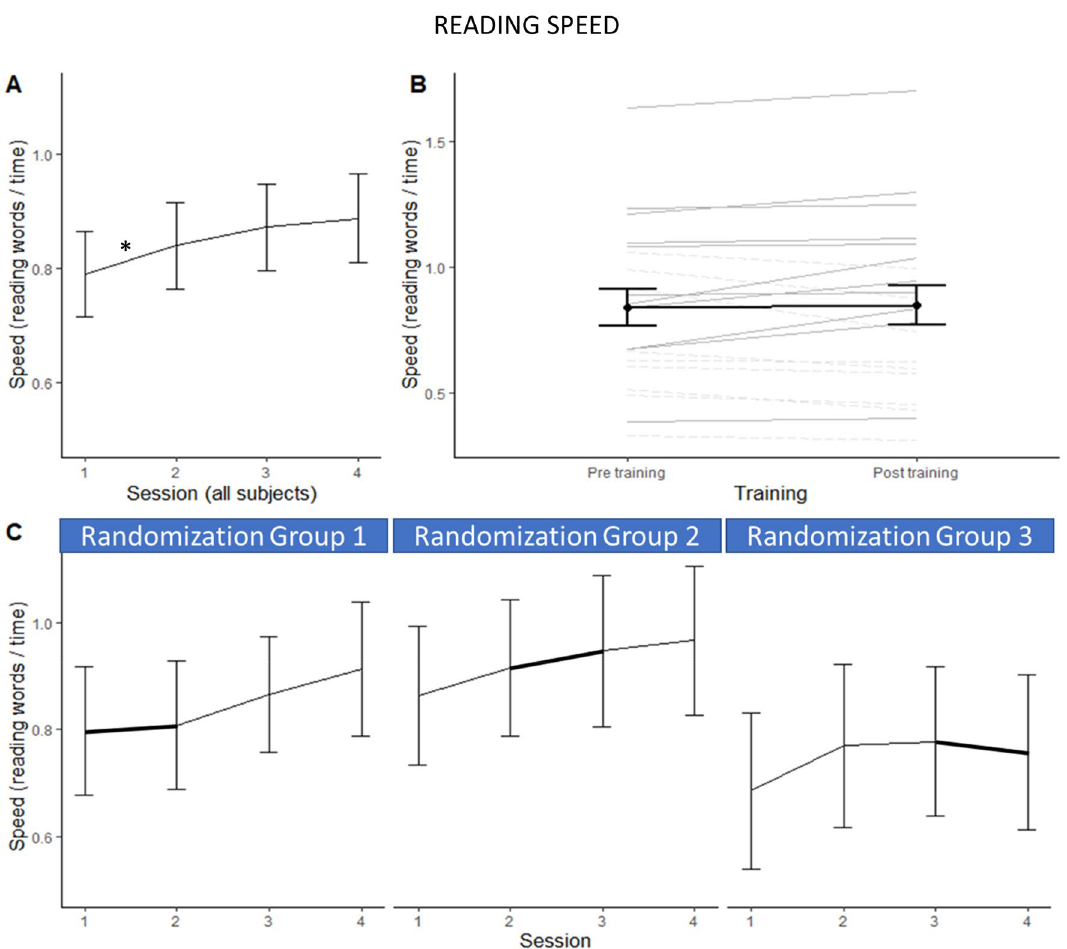
Figure 4. Mean reading speed and standard errors at the four reading sessions in the whole dyslexic group ( A ) and separately for the 3 randomization groups performing the visual search training at the first, the second or the third month ( C ). Mean reading speed just before (pre) and just after (post) the training month in the whole dyslexic group ( B —in black; and individual data displayed in grey).